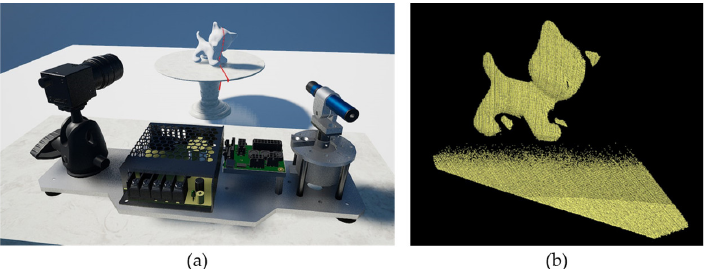
Figure 1. Three dimensional (3D) reconstruction using our system, ( a ) setup of the system, ( b ) reconstruction results.